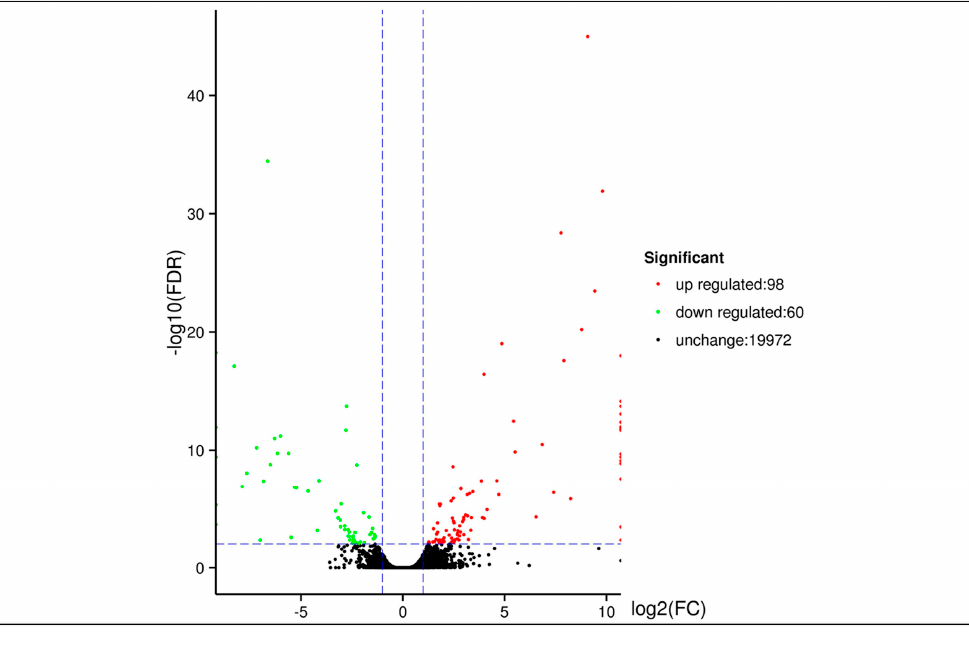
Figure 7. The Volcano Plot of DEGs. Table 4. The DEG Unigenes Count.